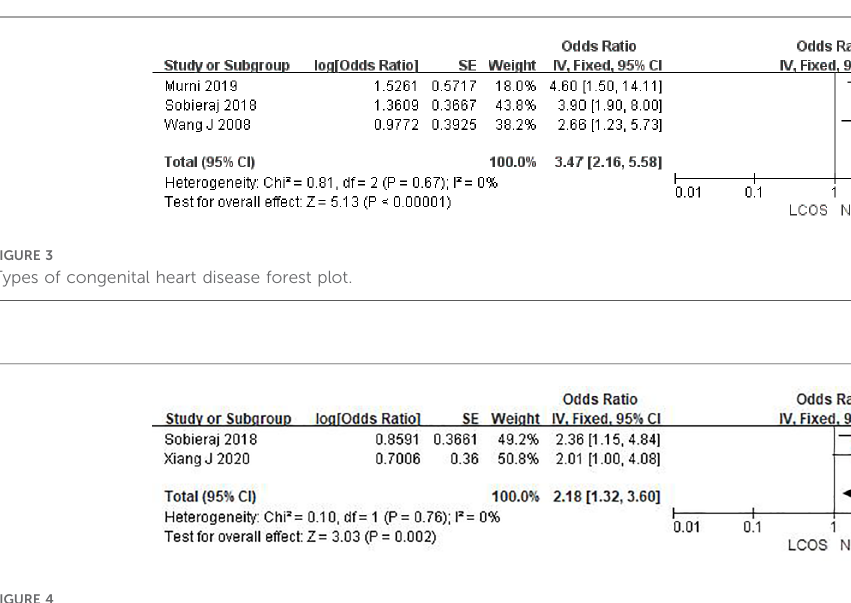
FIGURE 4 History of a cardiac surgery forest plot.